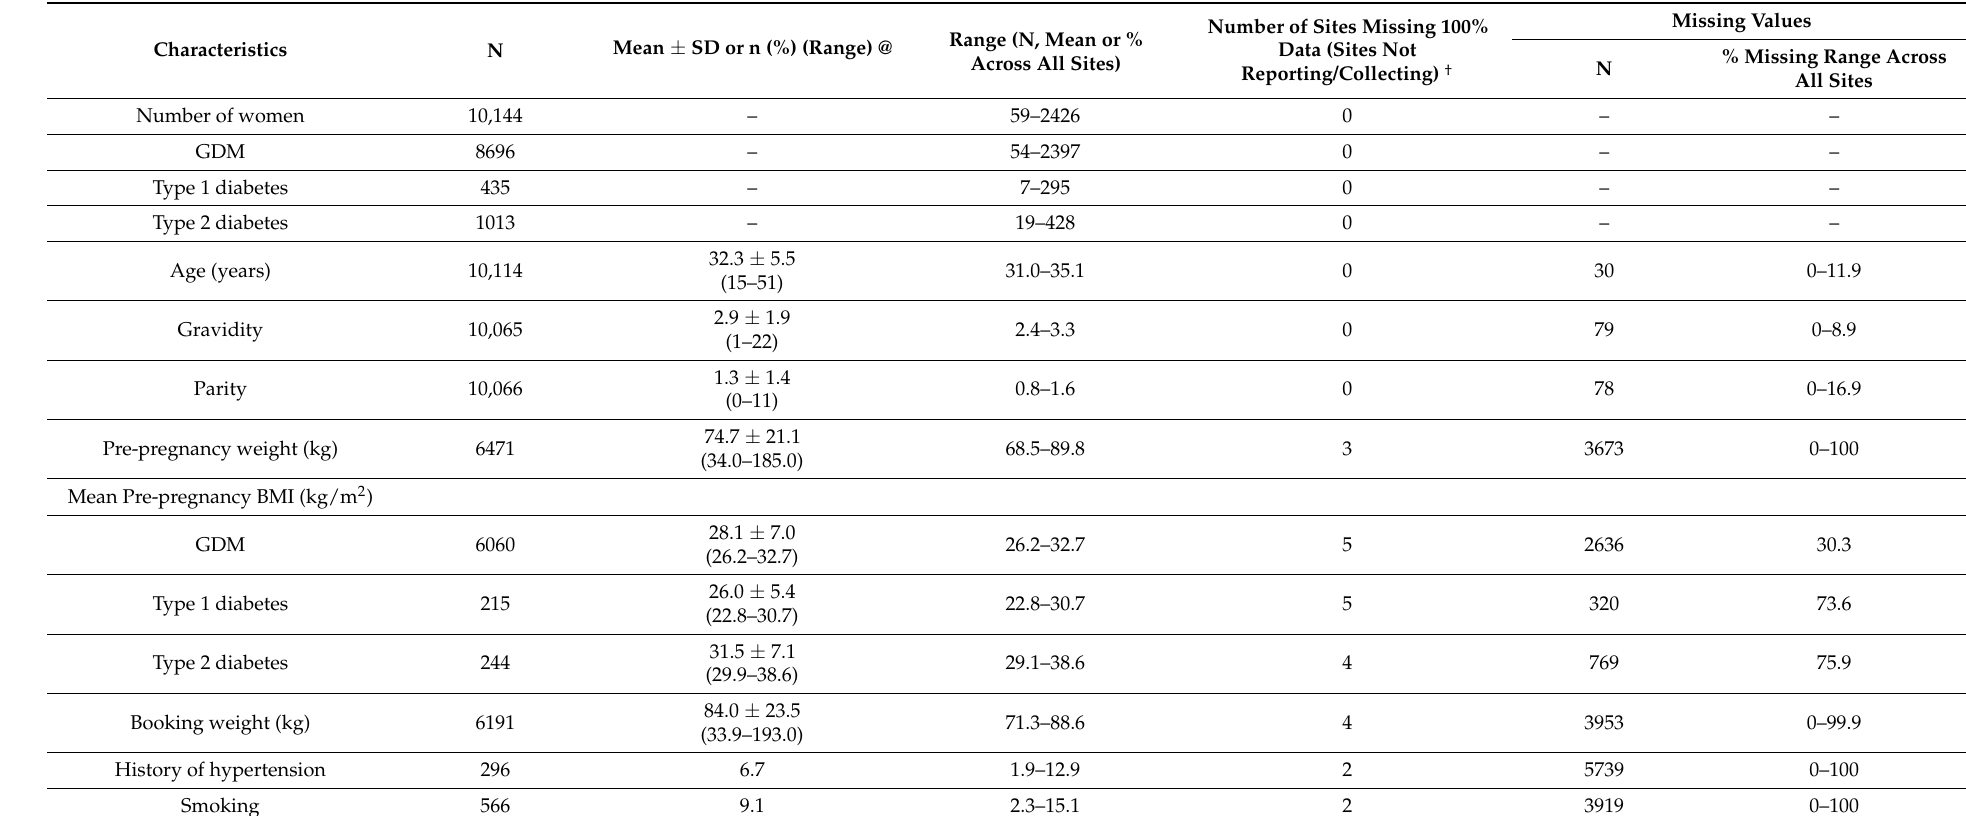
Table 3. Baseline characteristics of the study population (live singleton births